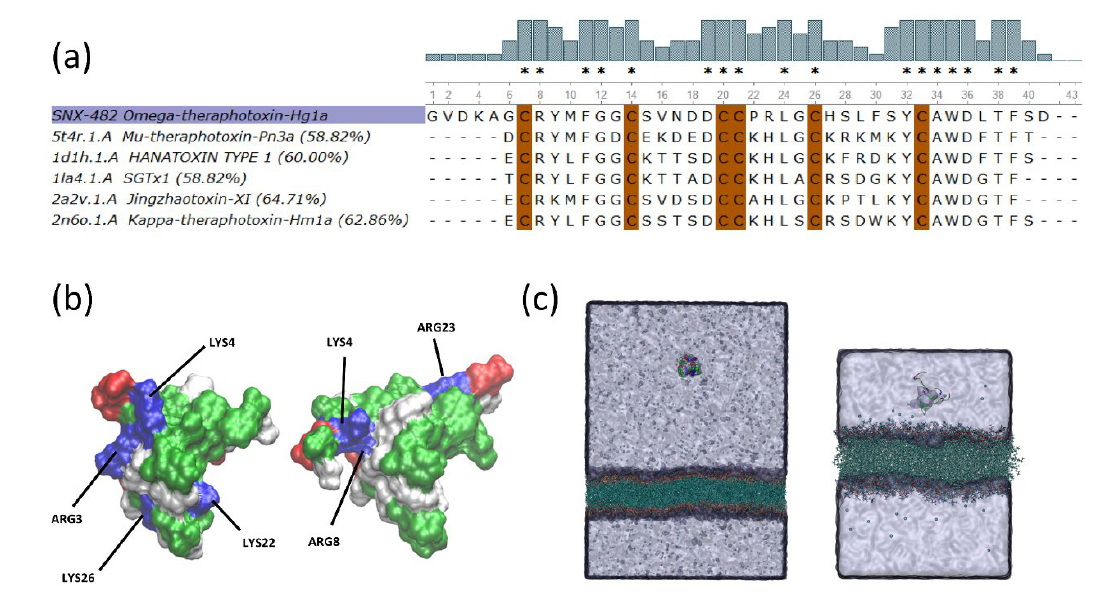
Figure 1. Comparative Modeling SNX-482. ( a ) Alignments of the five ICK toxins with the highest identity score to SNX-482. Identity score is included for each toxin. SNX-482(Omega-theraphotoxin- Hg1a) is highlighted in purple. Bars at the top of the alignment depict the percent identity at each position of the sequence. Conserved cysteines are highlighted in brown. (*) Identical residues ( b ) Surface representations of the Jingzhaotoxin-XI (left) and the SNX-482 (right) colored by residue type: positively charged (blue), negatively charged (red), and polar (white), hydrophobic (green). Both toxins’ structures are in the same orientation according to structural alignment. ( c ) The representative initial simulation system of the CG model (left) and the all-atom setup (right).